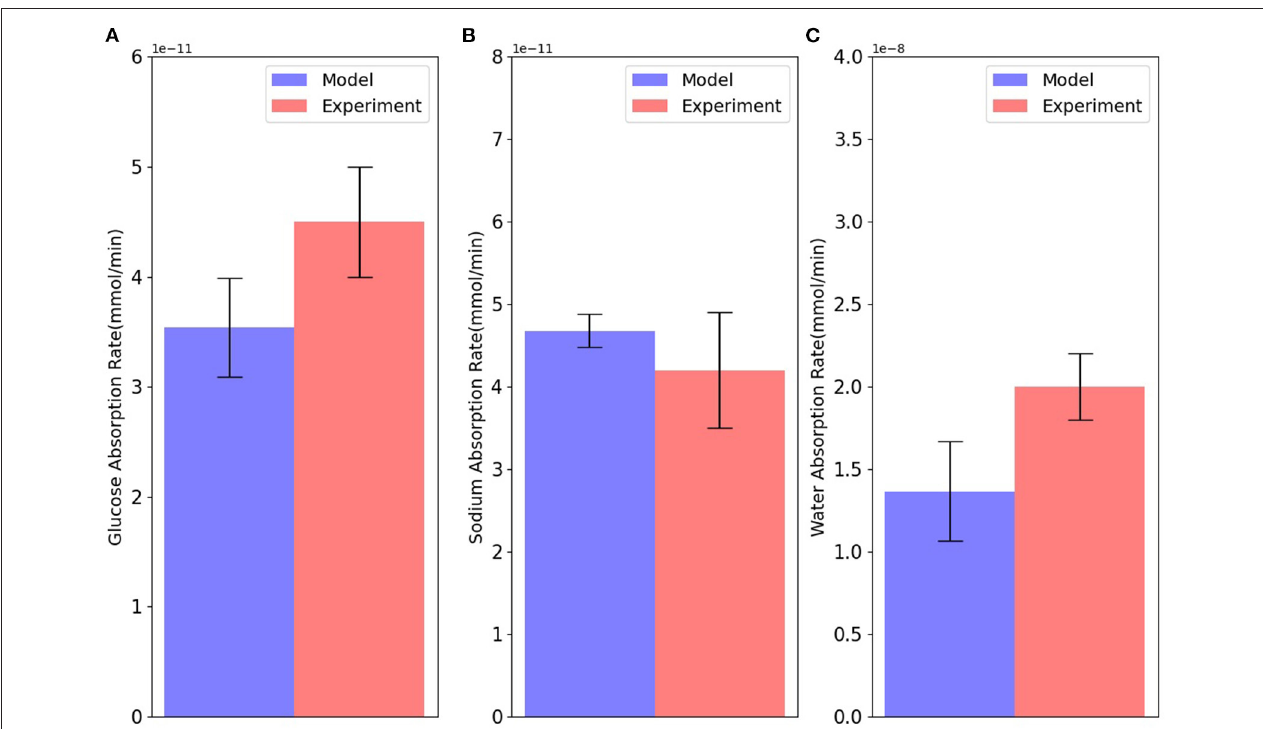
FIGURE 4 | Absorption rates of (A) glucose; (B) sodium; and (C) water through the cell in comparison with intestinal loop data. Error bars in the model represent different values for inlet blood flow. Experimental bars are mean ± SE with 6 tests ( Collin et al., 1978).